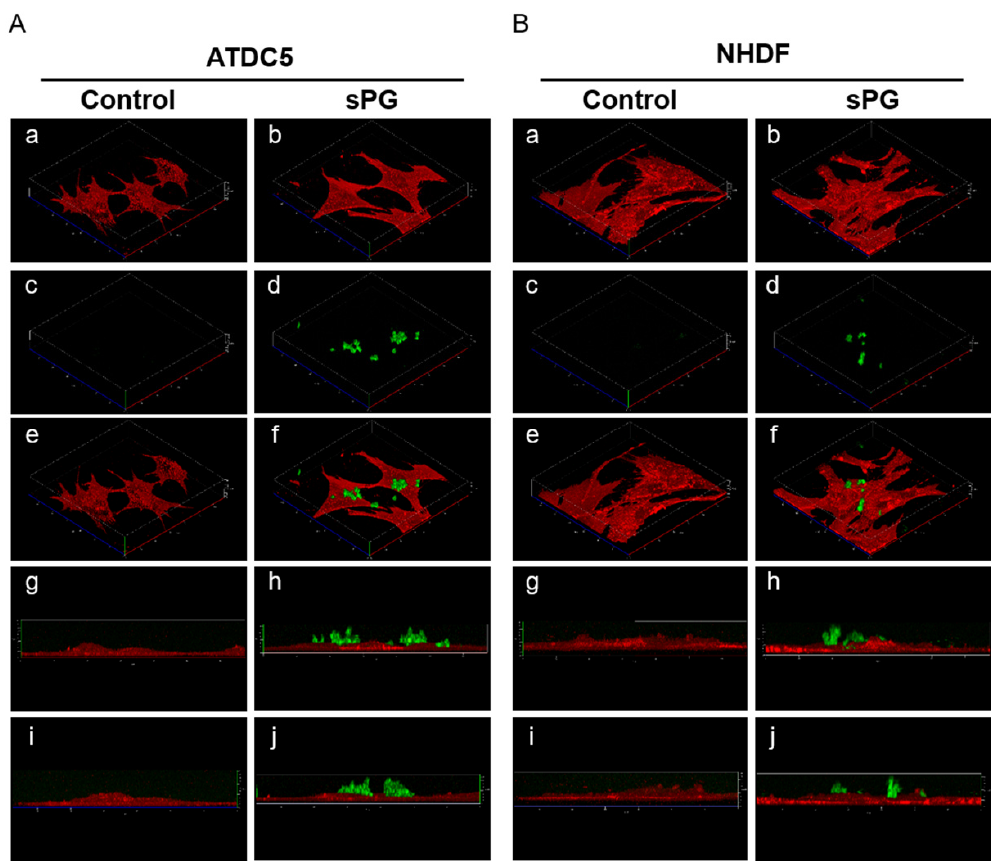
Figure 9. Three-dimensional live cell imaging of sPG localization using Confocal Laser Scanning Microscopy (CLSM). Three-dimensional localization analysis of sPG in ATDC5 cells ( A ) and NHDF cells ( B ). ATDC5 cells or NHDF cells were treated ATTO 488 alone (Control) or ATTO 488-labeled sPG for 30 min. After washing with PBS, each cell was treated with CellMask for 30 min. After each cell was also washed with PBS, optical sectioning of the live cells were acquired using CLSM at 24 h. In both A and B, ( a – f ) indicate the XYZ three-dimensional, ( g , h ) indicate the XZ-section, and ( i , j ) indicate the YZ-section. ( a , b ) indicate a cell membrane using CellMask, ( c , d ) indicate ATTO 488 alone or ATTO 488-labeled sPG, and ( e – j ) indicate each Merge.